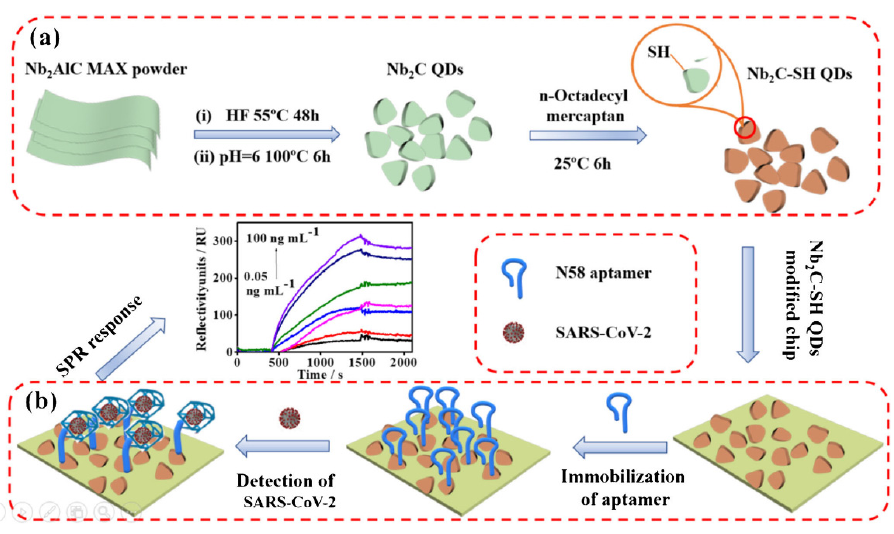
Figure 6. ( a ) Synthesis of Nb 2 C-SH QDs. ( b ) Fabrication of an Nb 2 C-SH QD-based SPR aptasensor for SARS-CoV-2 N-gene detection. (Reprinted by permission [166]. Copyright © 2022, Springer Nature Switzerland AG. Part of Springer Nature.)